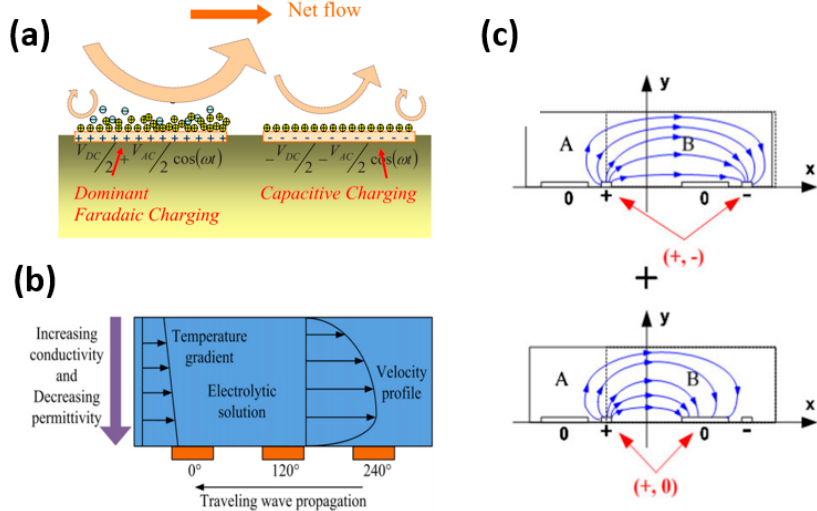
Figure 2. Schematic of different mechanisms for imposing asymmetry to the electric field in alternating current electrothermal effects (ACET) devices. ( a ) Direct current (DC) biased configuration. The left electrode is always at a positive potential and subject to faradaic charging, while the right electrode is always at a negative potential and subject to capacitive charging. ( b ) Travelling wave configuration. The induced temperature gradient generates a charge density which is moved with the travelling electric field. Note that the direction of propagation of travelling wave is opposite to the direction of fluid flow. ( c ) Two-phase asymmetric configuration. The narrow electrodes in two adjacent pairs have different polarities. The superposition of the two configurations enhances the electric field in region B. Reproduced with permission from [6,68,69].